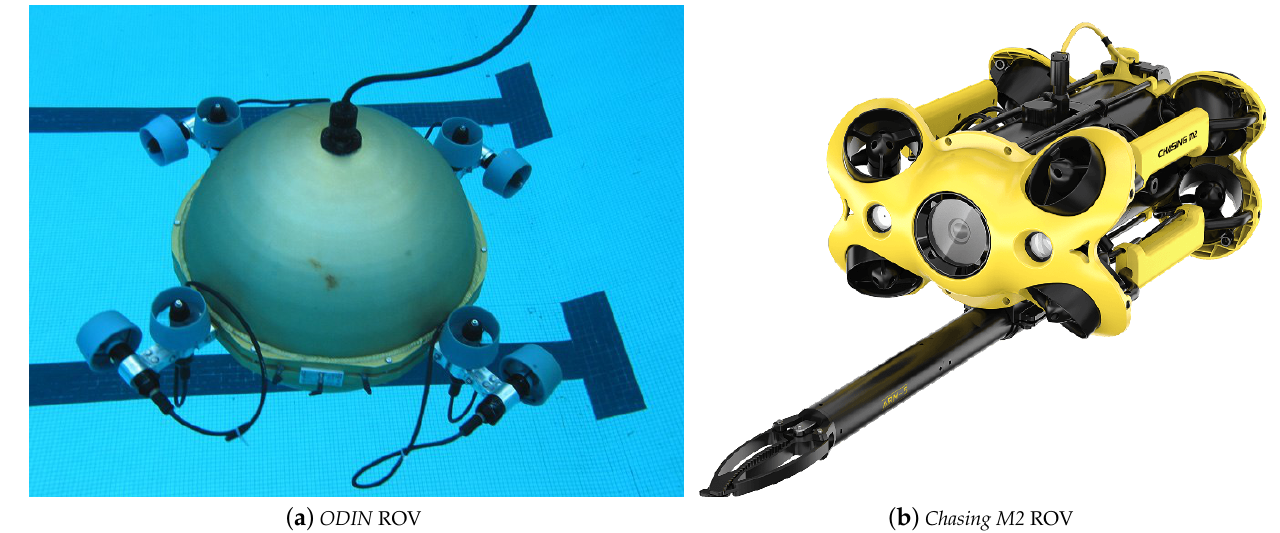
Figure 4. Examples of robots with fixed vectorial thrusters